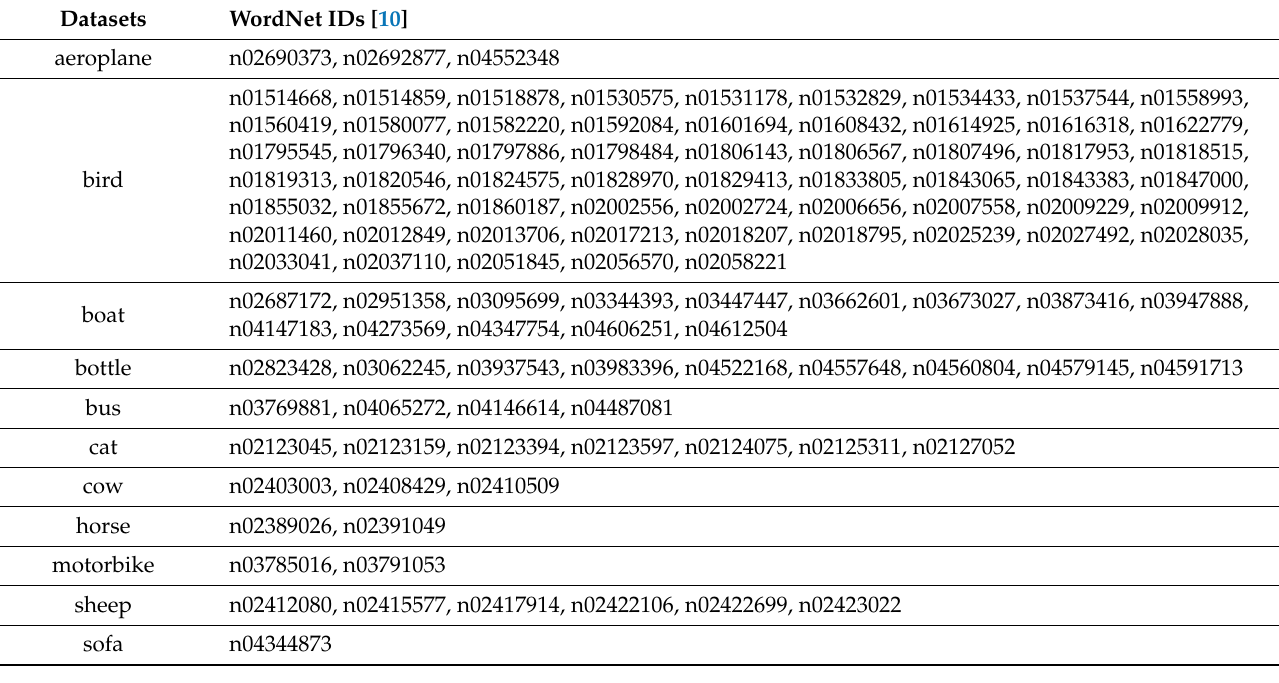
Table 3. The removed new classes.